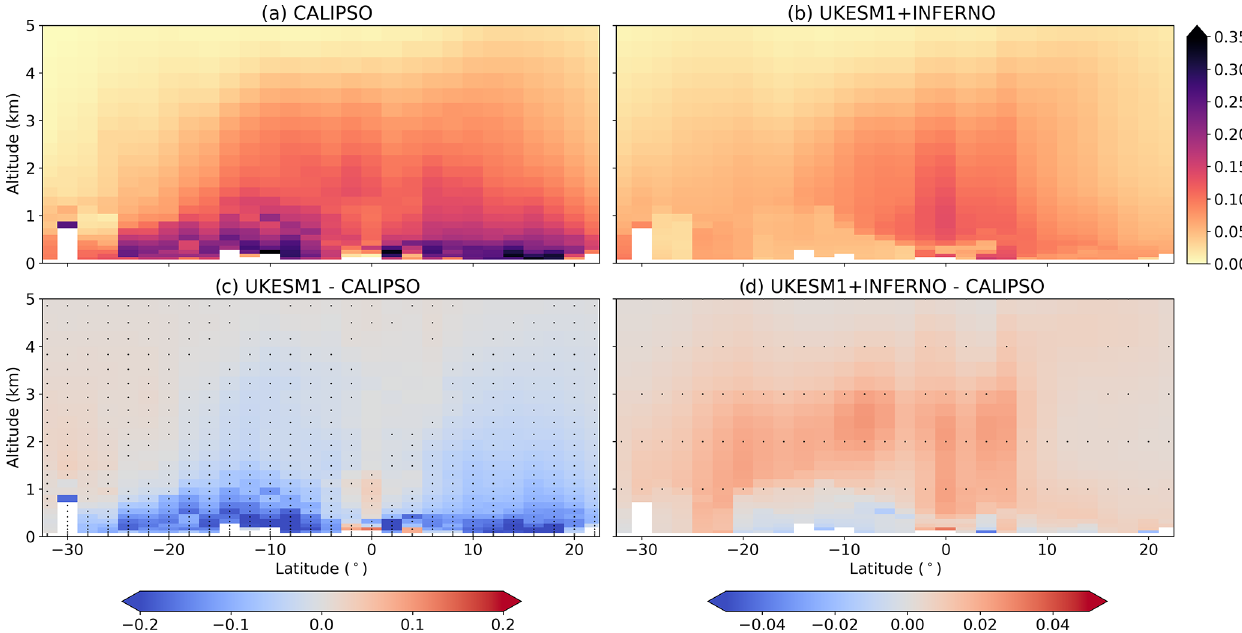
Figure 14. Aerosol extinction coefficient mean (km − 1 ) annual average vertical cross section at 532nm (2006–2014) covering the African continent (extending both NHAF and SHAF regions) for (a) CALIPSO, (b) UKESM1+INFERNO, (c) difference between UKESM1 and CALIPSO, and (d) difference between UKESM1+INFERNO and UKESM1. Stapling is shown for points where the differences are statisti- cally significant with a 95% confidence level.